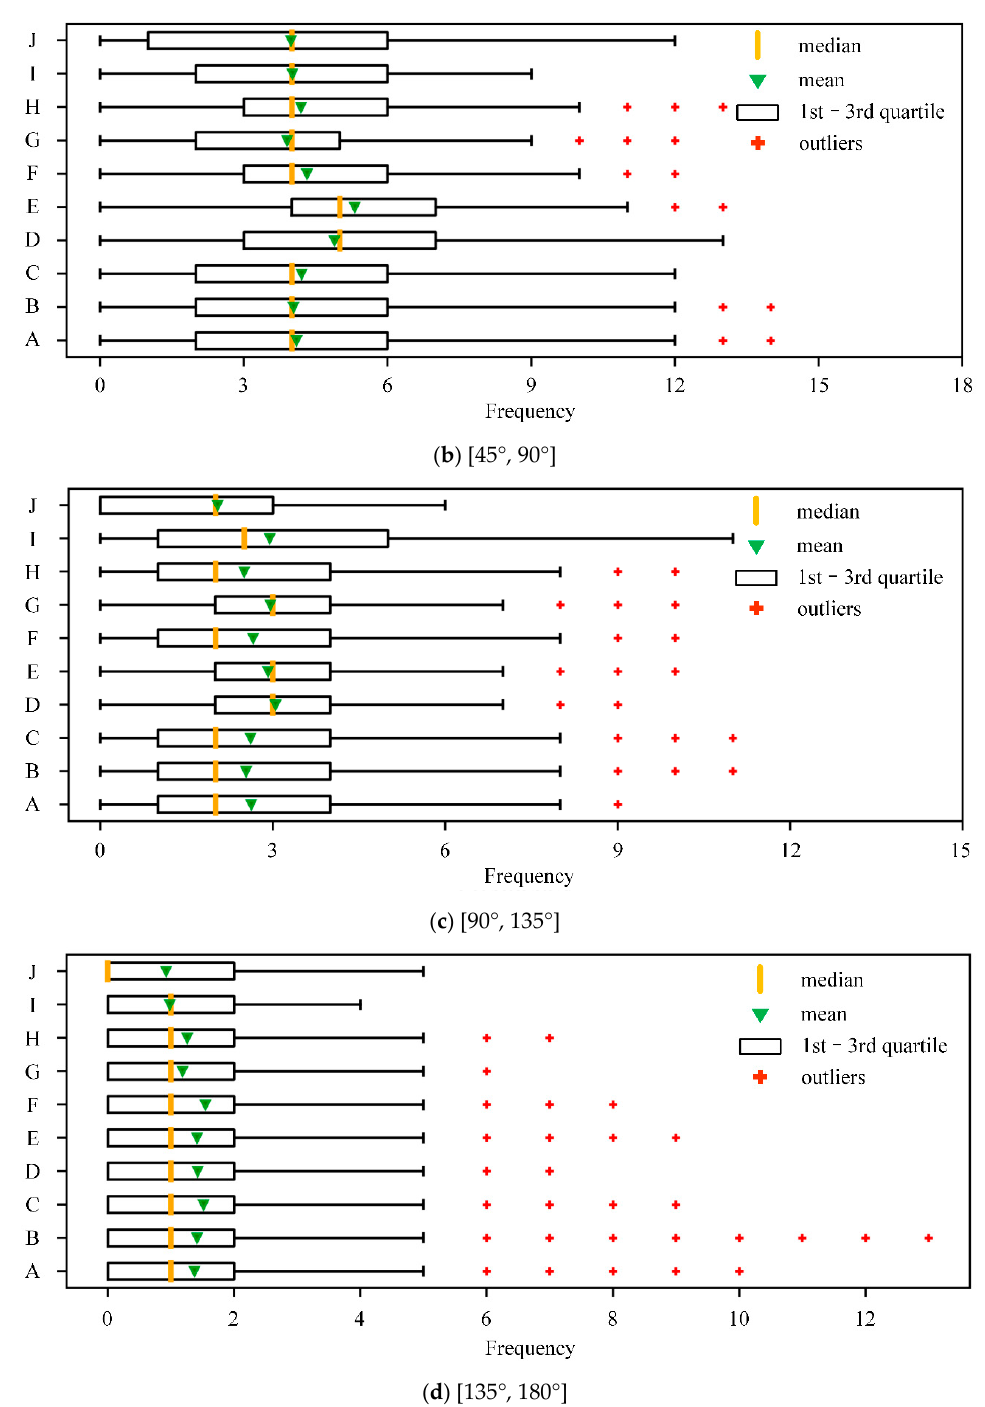
Figure 5. The frequency of the directional change of GS in the four intervals.